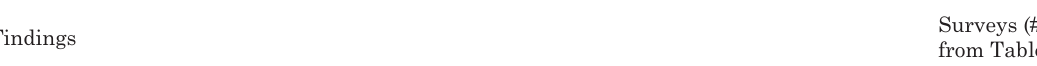
Table 2. Summarized findings relating to perceptions of a mismatch between skills demand and